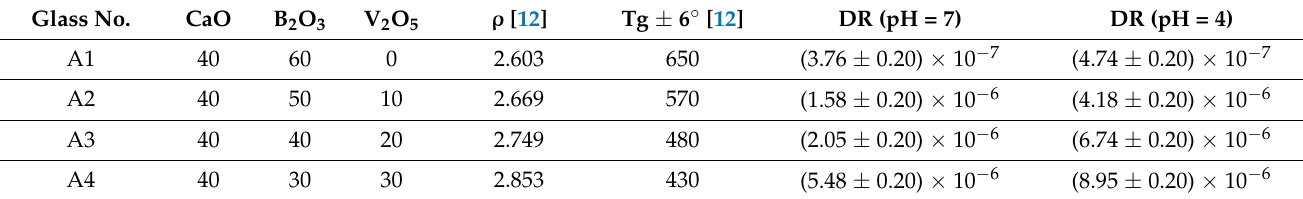
Table 1. Composition (mol %), density ρ (g · cm − 3 ), glass transition temperature Tg ( ◦ C), and dissolu- tion rate (DR) (g/cm 2 /min) of the studied